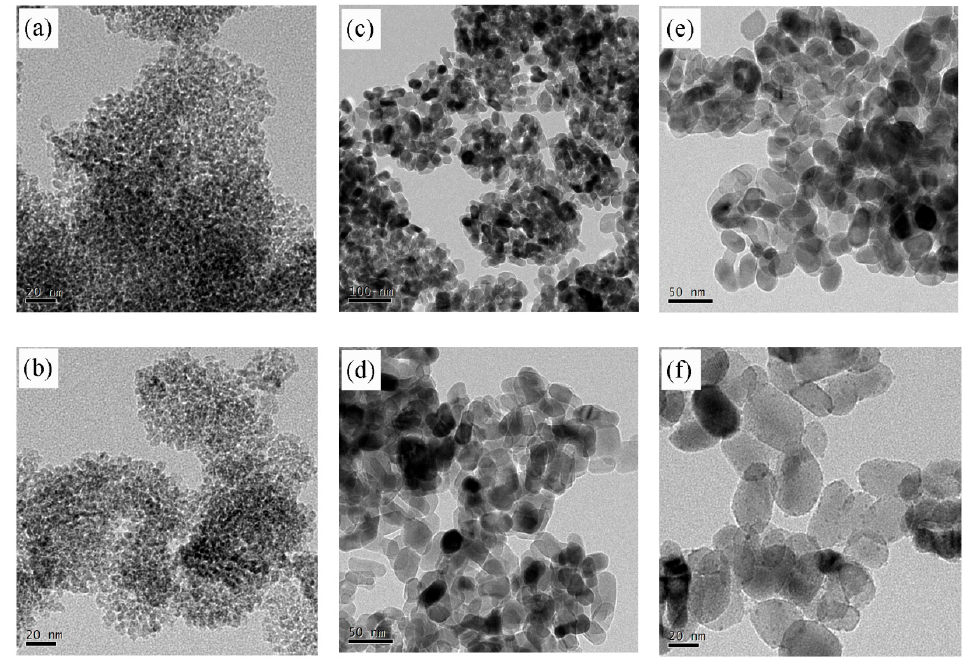
Figure 2. TEM graphs of the TNPs samples: ( a , b ) TNPs-1, ( c , d ) TNPs-2, and ( e , f ) TNPs-3. Pyridine adsorption experiments on the TNPs were carried out to identify the presence of Lewis and/or Brønsted surface acid sites, and the results are displayed in Figure 3. There are two main characteristic peaks observed in the regions of 1400–1452 cm − 1 and 1570–1620 cm − 1 . These absorption bands assigned to the pyridine molecules align with Lewis acid sites, suggesting the presence of Lewis acid sites in the TNPs. There is a weak characteristic peak observed at approximately 1555 cm − 1 , which is assigned to the adsorption of pyridine at the Brønsted acid sites [48]. In addition, the distinct band at approximately 1489 cm − 1 is ascribed to both Brønsted and Lewis acid sites [49,50]. Moreover, it was seen that with an increase in the desorption temperature from 100 to 300 ◦ C , these bands showed slow decreases in intensity. The above observations